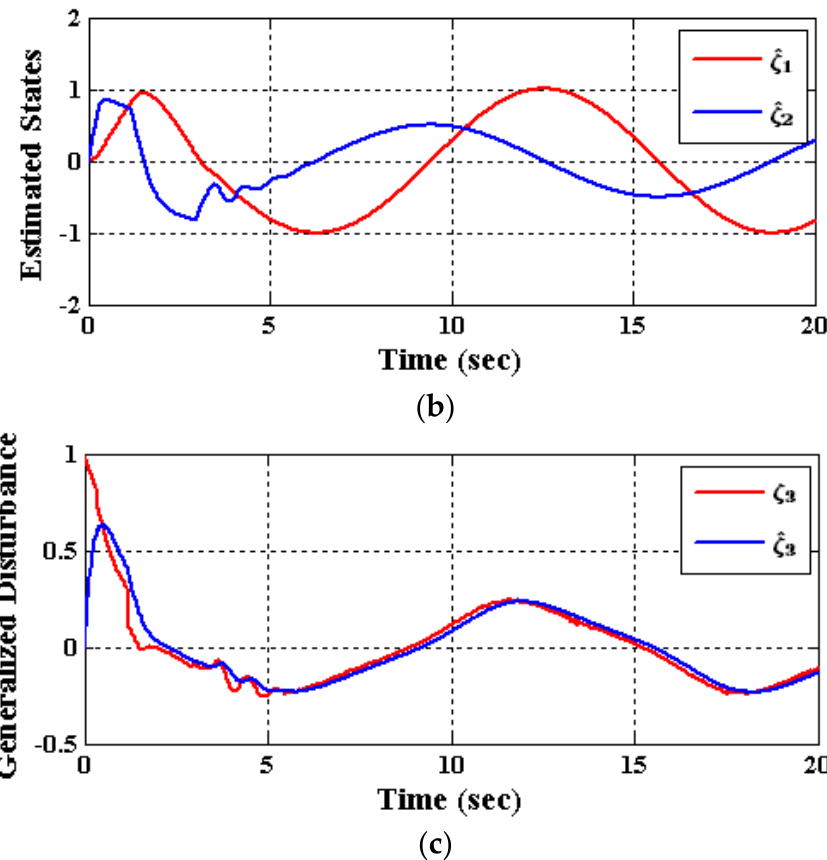
) (cid:3021) ; ( b ) estimated , 𝜉 (cid:2869) (cid:2870)